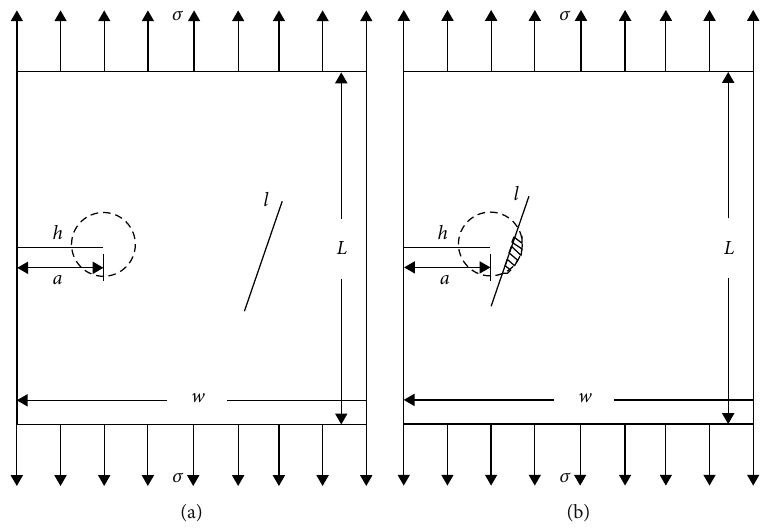
Figure 10: Schematic of the two-crack example: (a) case 3; (b) case 4.